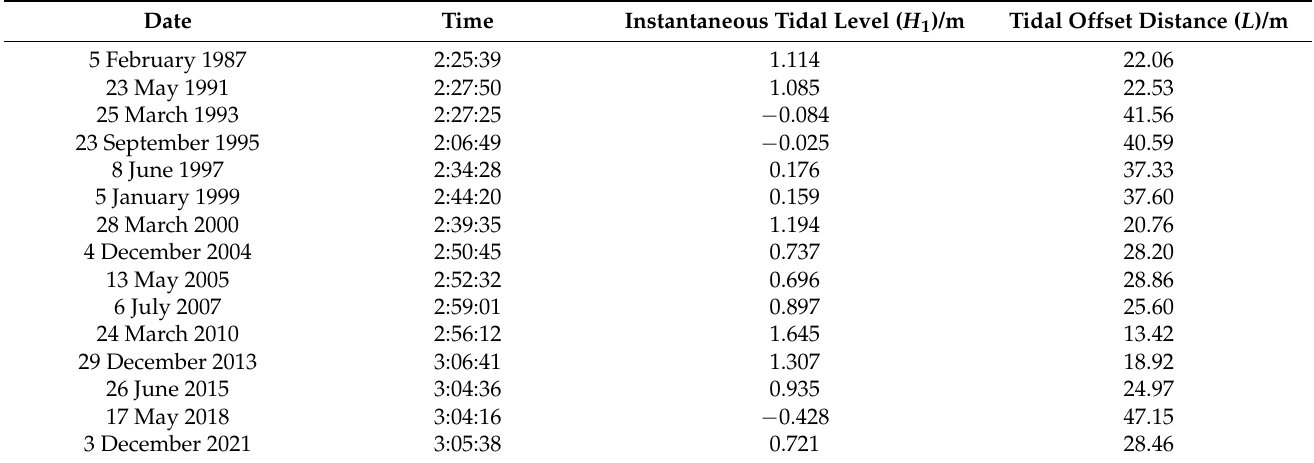
Table 2. Geometric offset correction for the distance of the instantaneous waterline.